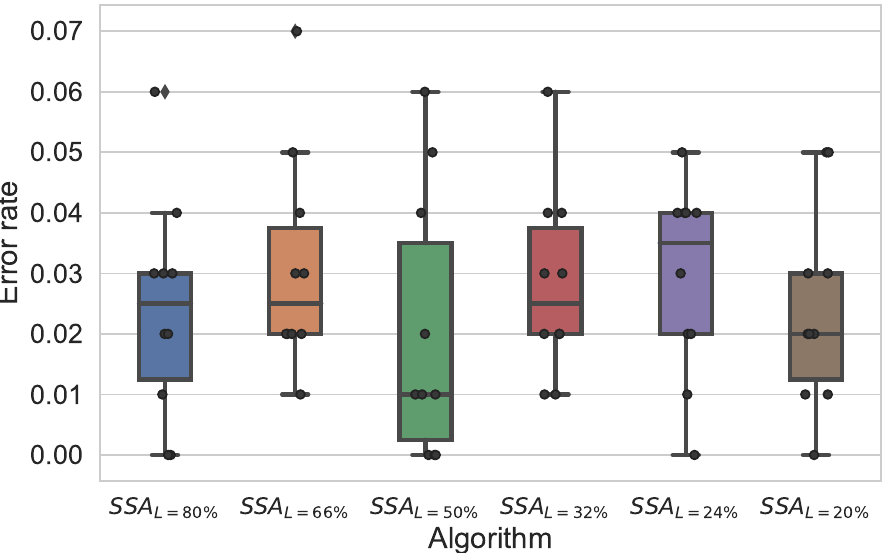
Figure 8. Box plots presentation of the SSA algorithm at different ratios of